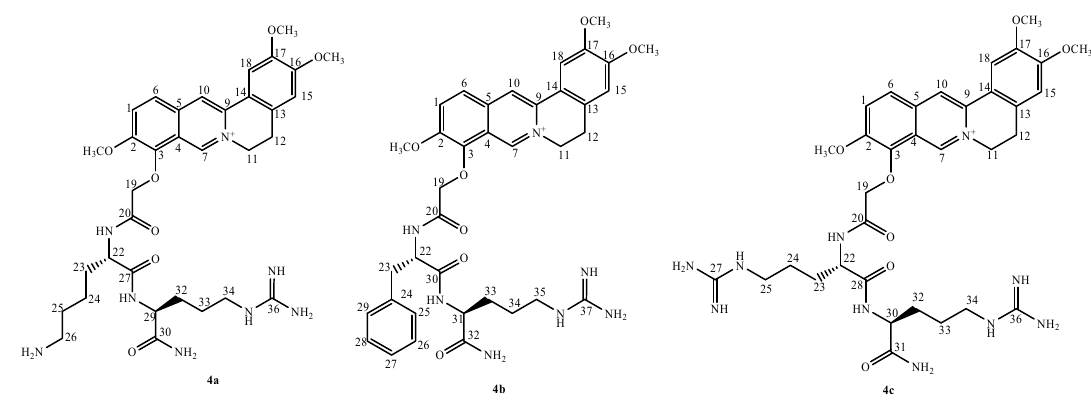
Figure 4. Structures of compounds ( 4a – 4c ).